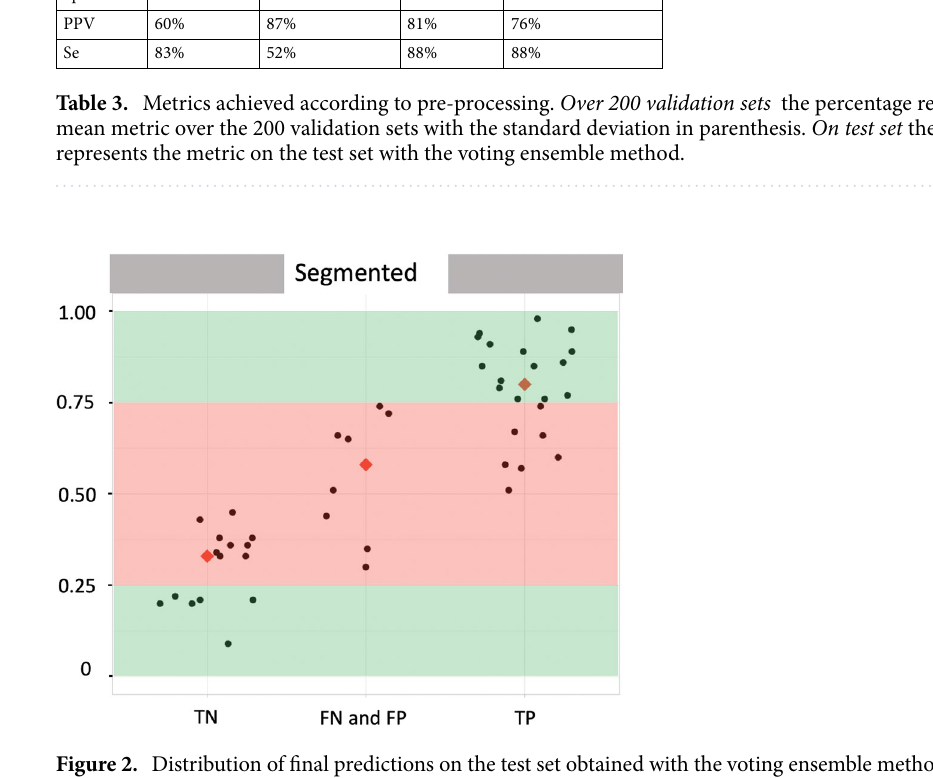
Figure 2. Distribution of final predictions on the test set obtained with the voting ensemble method. Green areas final predictions of these areas correspond exclusively to correct classifications (True Negative for final predictions lower than 0.25; True Positive for final predictions higher than 0.75). Red area all incorrect classifications and a part of correct classifications have their final prediction in this area. Red diamond The median of each of the three groups is represented by a red